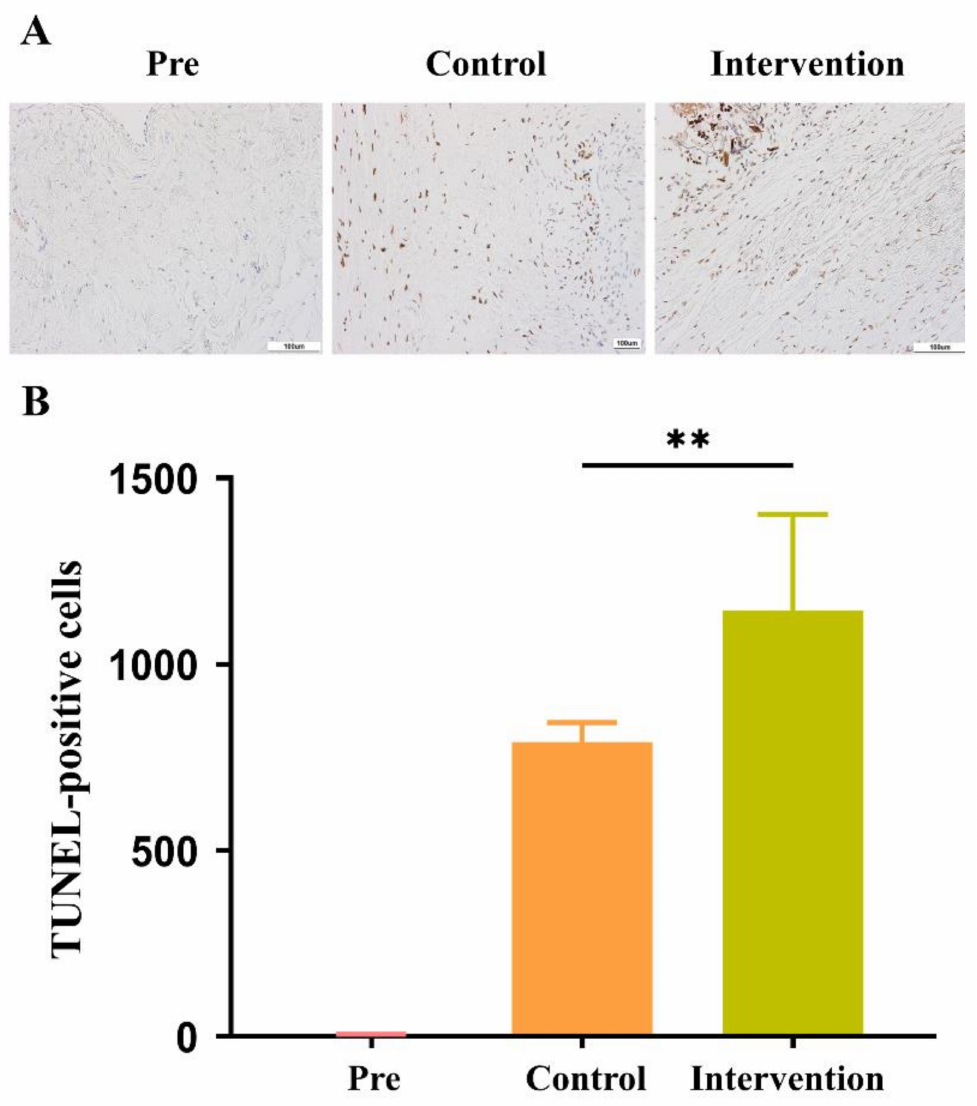
Figure 8. Cell apoptosis examined with terminal deoxynucleotidyl transferase dUTP nick-end labeling (TUNEL) staining. ( A ) Apoptotic cells (brown) shown after TUNEL staining and ( B ) the number of apoptotic cells counted at 200 × magnification in an average of four sections per stained slide using Image J (** p < 0.01). Scale bars indicate 100 µ